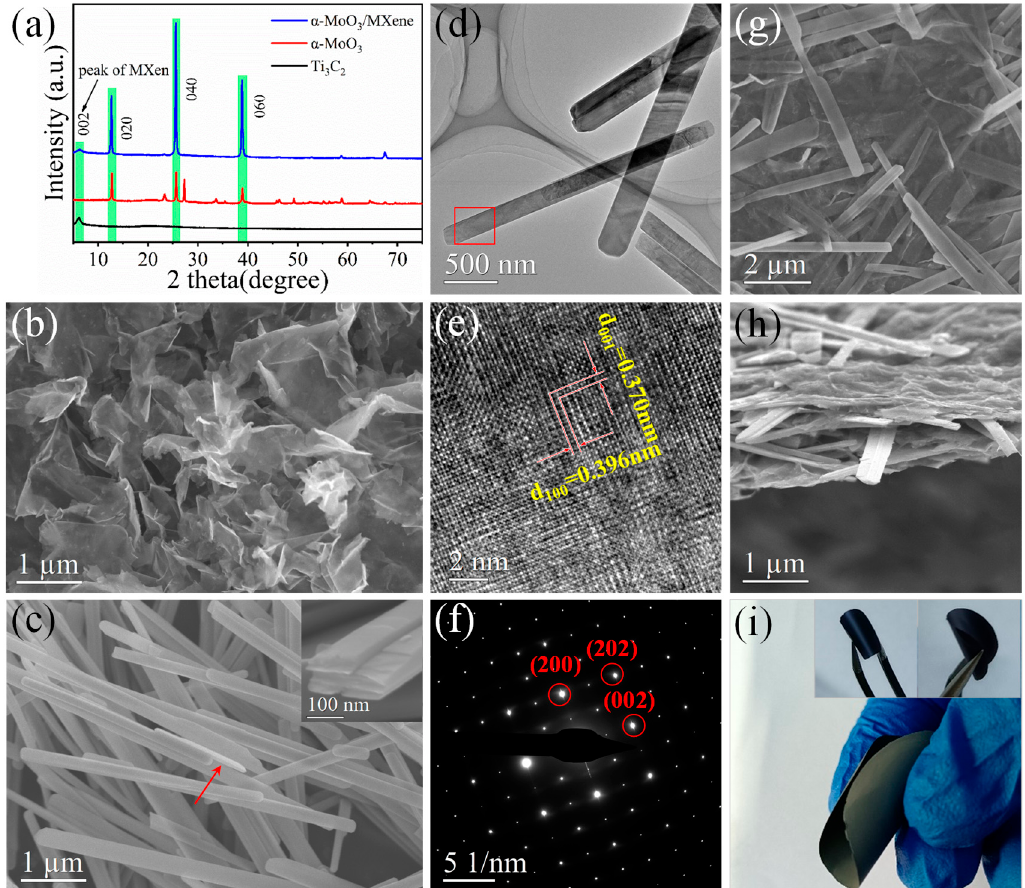
Figure 1. ( a ) XRD diffraction patterns of Ti 3 C 2 , MoO 3 , and MoO 3 /MXene. ( b ) SEM image of Ti 3 C 2 . ( c ) SEM image of α -MoO 3 . ( d ) TEM image of α -MoO 3 . ( e ) HR-TEM image of α -MoO 3 . ( f ) SAED pattern of α -MoO 3 . ( g , h ) SEM images of α -MoO 3 /MXene. ( i ) Photographs of free-standing α -MoO 3 /MXene film and